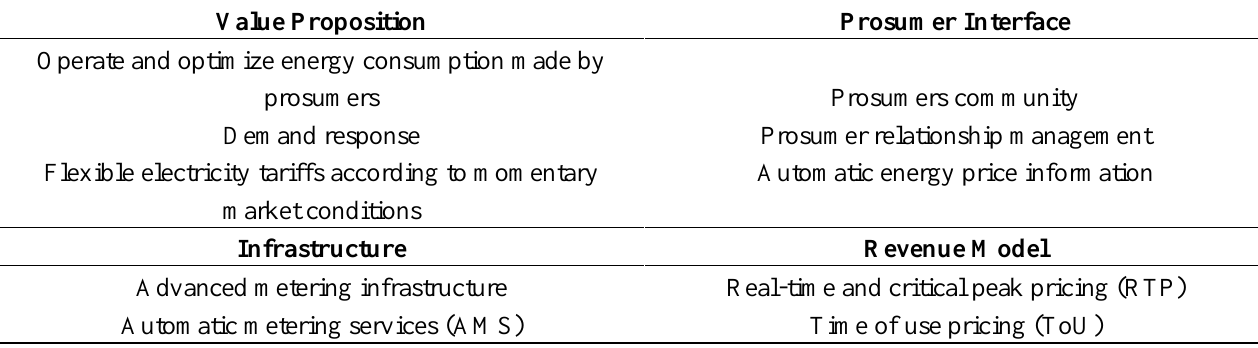
Table 6. Aggregator/retailer prosumer-oriented business model characteristics.